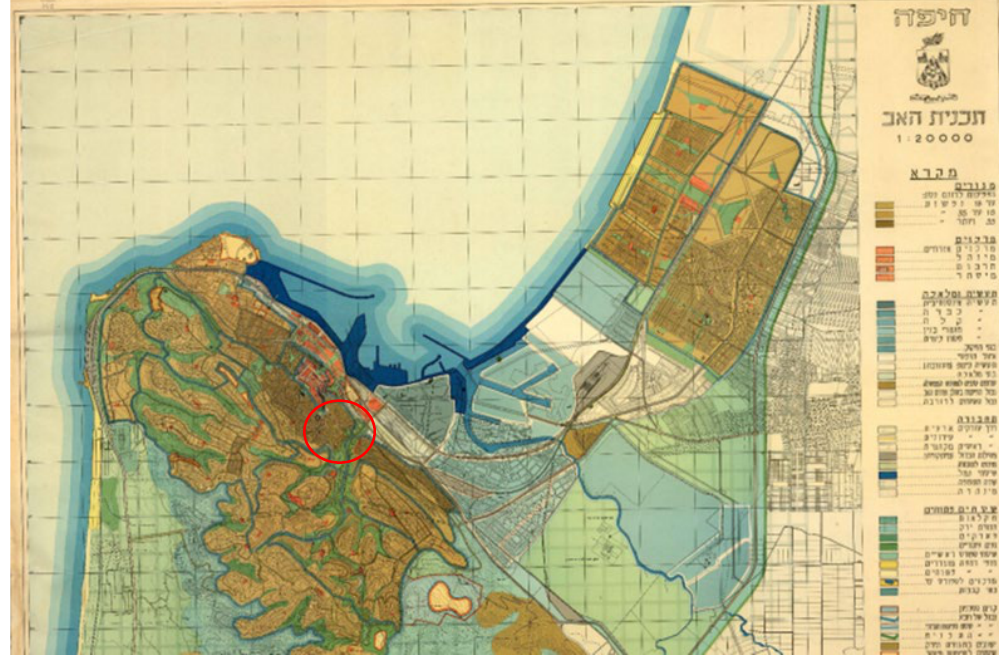
Figure 6 TPF 1954, Master Plan for Haifa by the Office for Master Plan of Haifa, Source: the Haifa City